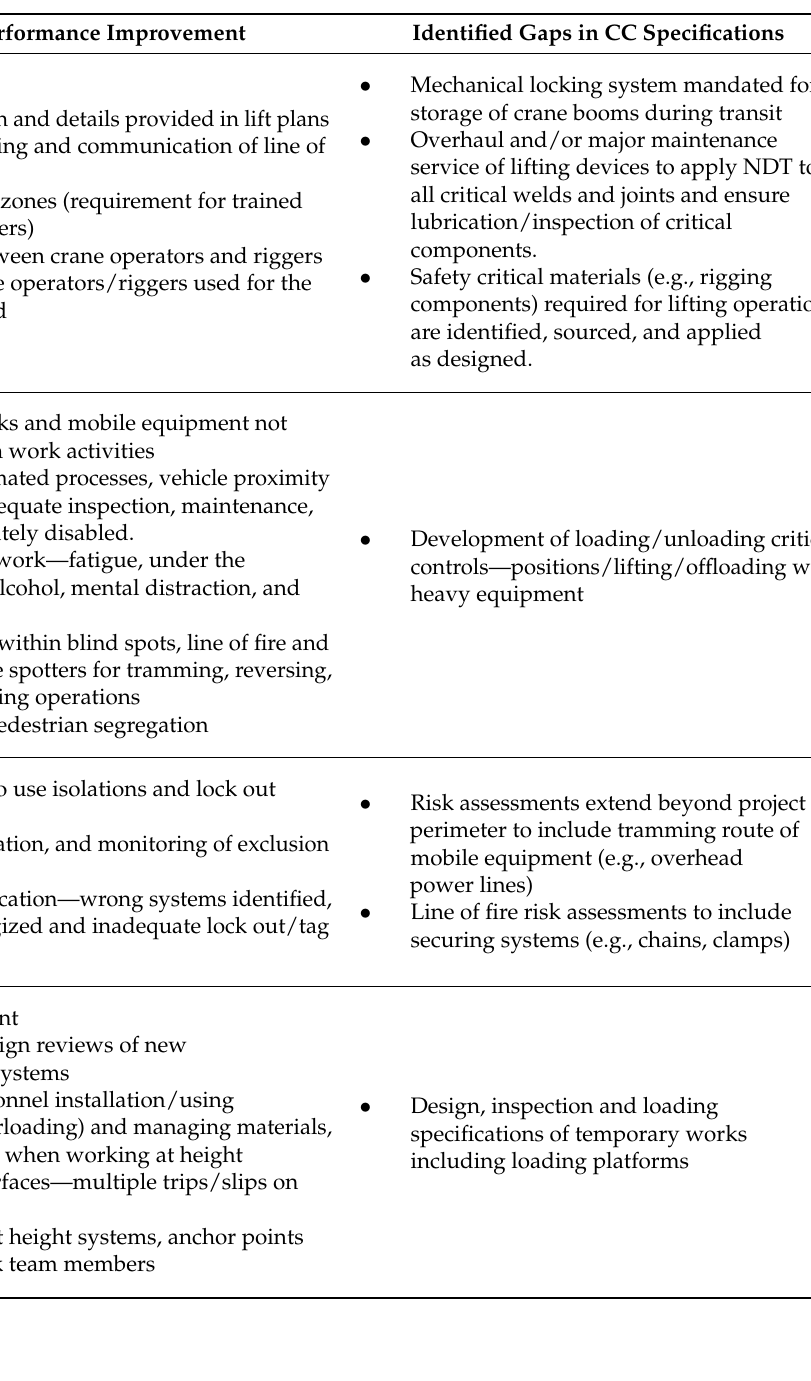
Table 4. Identified improvements and gaps in Critical Controls by MAE